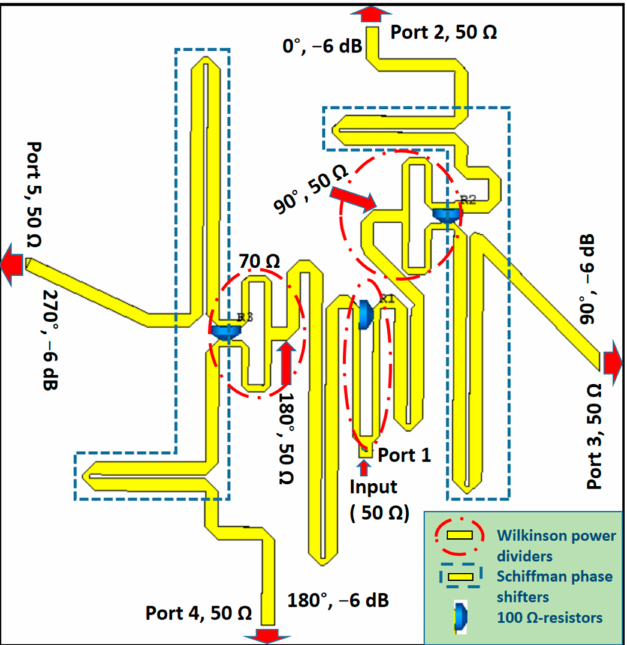
Figure 4. Schematic of hybrid feed network based on the Schiffman phase